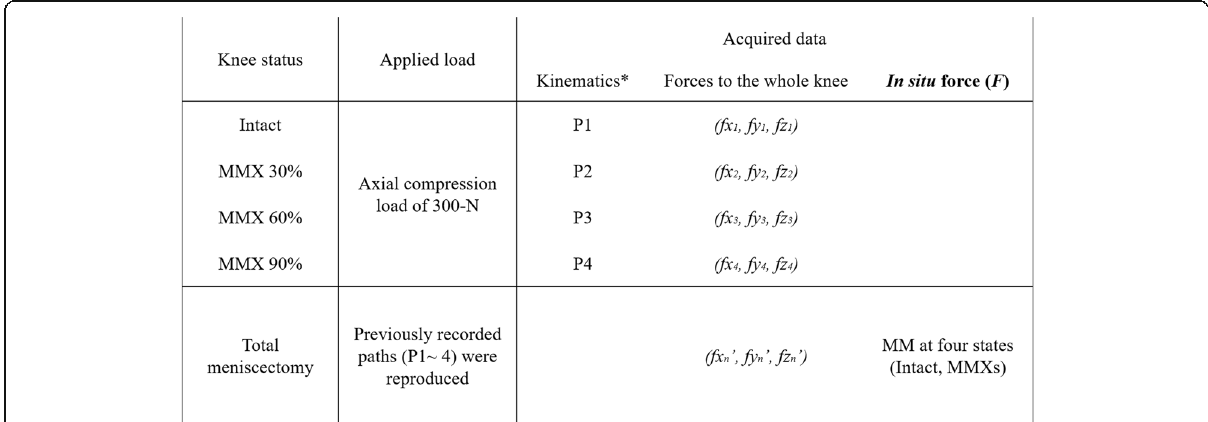
Fig. 4 Testing protocol and data acquisition. *Varus/valgus and internal/external changes (°) during compression load